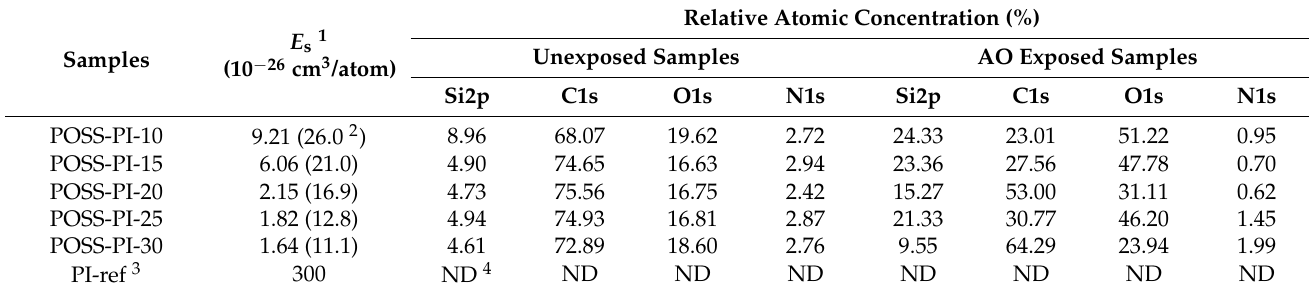
Table 4. XPS results for the unexposed and exposed POSS-PI composite films.